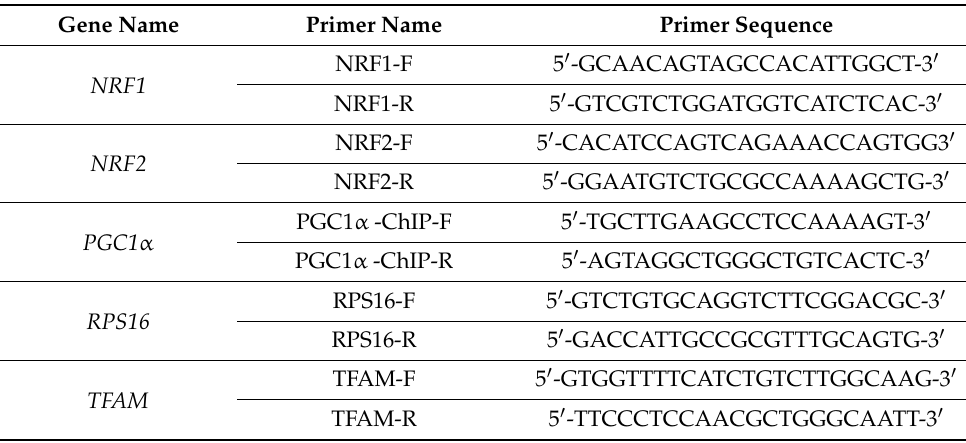
Table 2. List of Primers used for